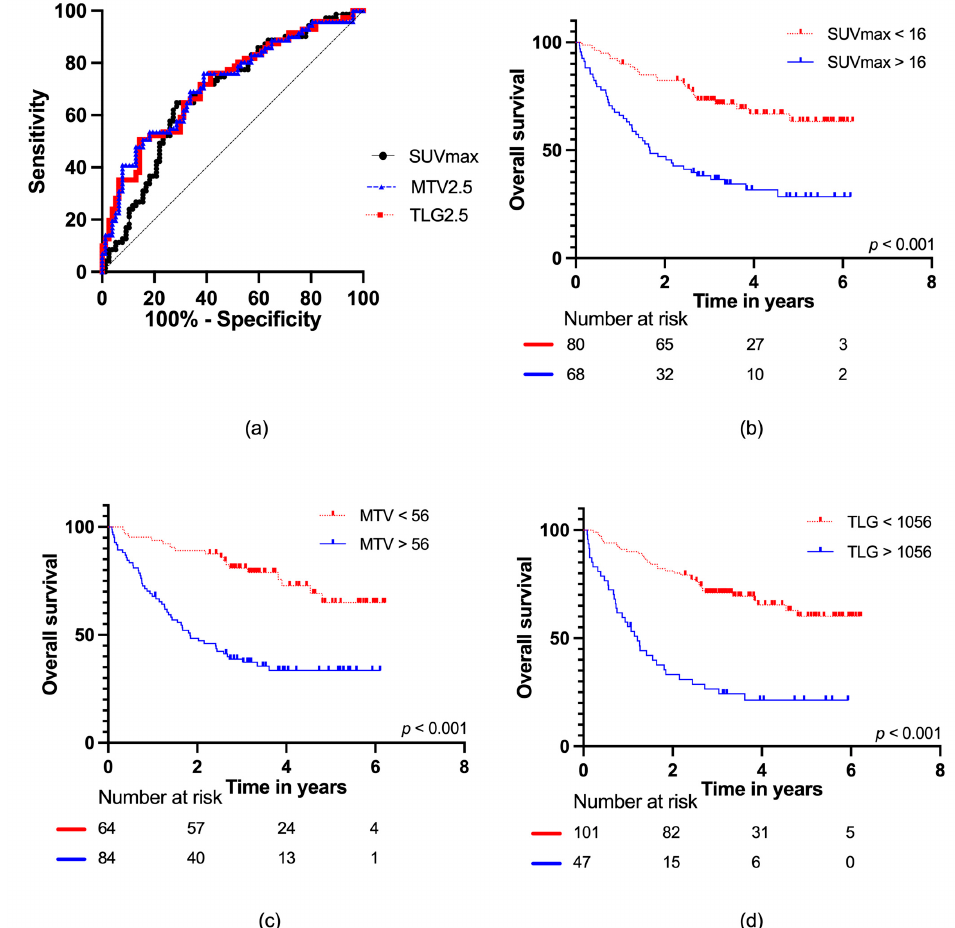
Figure 3. ( a ) ROC curves for SUVmax, MTV2.5, and TLG2.5 for all patients; Kaplan–Meier survival curves with number at risk at baseline, two, four, and six years for ( b ) SUVmax; ( c ) MTV2.5; and ( d ) TLG2.5.